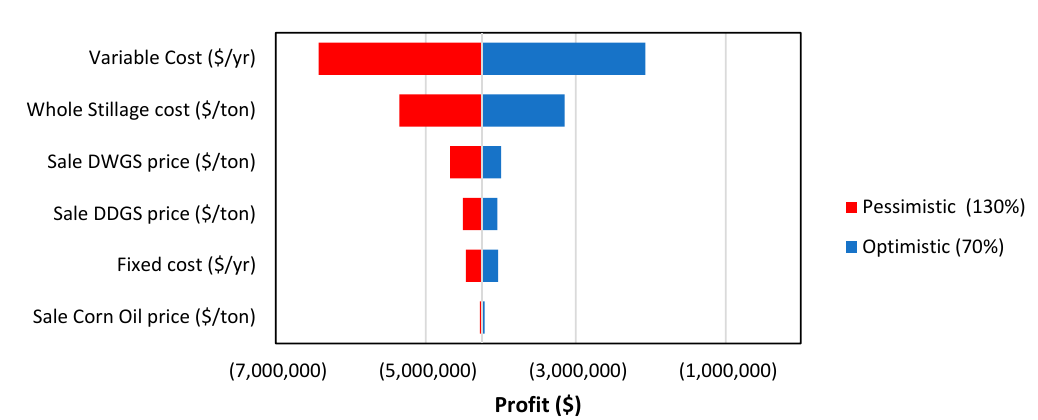
Figure 7. Sensitivity analyses of conventional system as a function of DDGS, DWGS, and corn oil prices from ‒ 30% (pessimistic case) to +30% (optimistic).